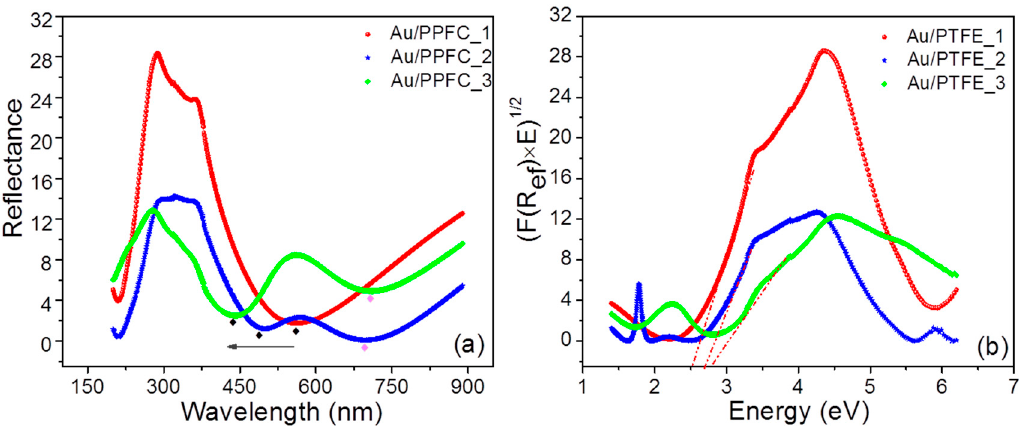
Figure 6. ( a ) UV-Vis spectra of three Au/PPFC MPNCs at room temperature; the local surface plasmon resonance (LSPR) in the three MLs are indicated by a diamond symbol ( ♦ ) and the arrow indicates the shift in LSPR. ( b ) Plot of [ 𝐹 (cid:3435)𝑅 (cid:3032)(cid:3033) (cid:3439) × (h 𝜈 )] vs. energy for indirect band gap calculation by applying linear approximations (fits are indicated by the red dash-dotted lines).